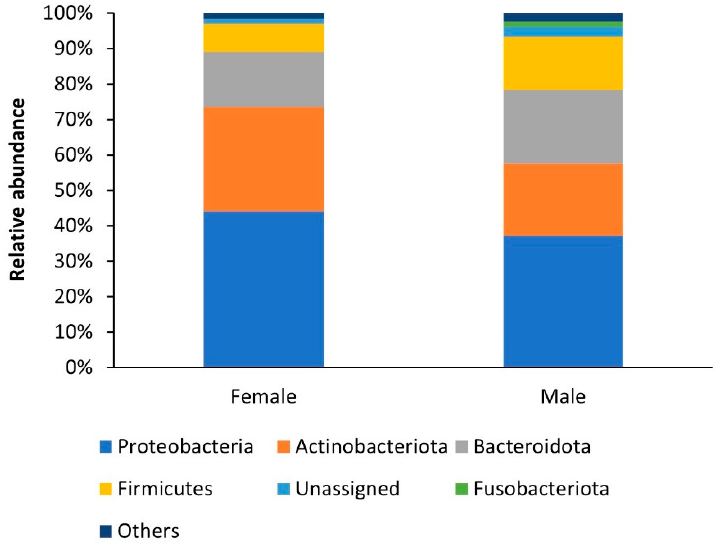
Figure 1. Bacterial community composition in female and male P. cylindrus mycangia. Bar charts show the relative abundance of bacteria at the phylum level.